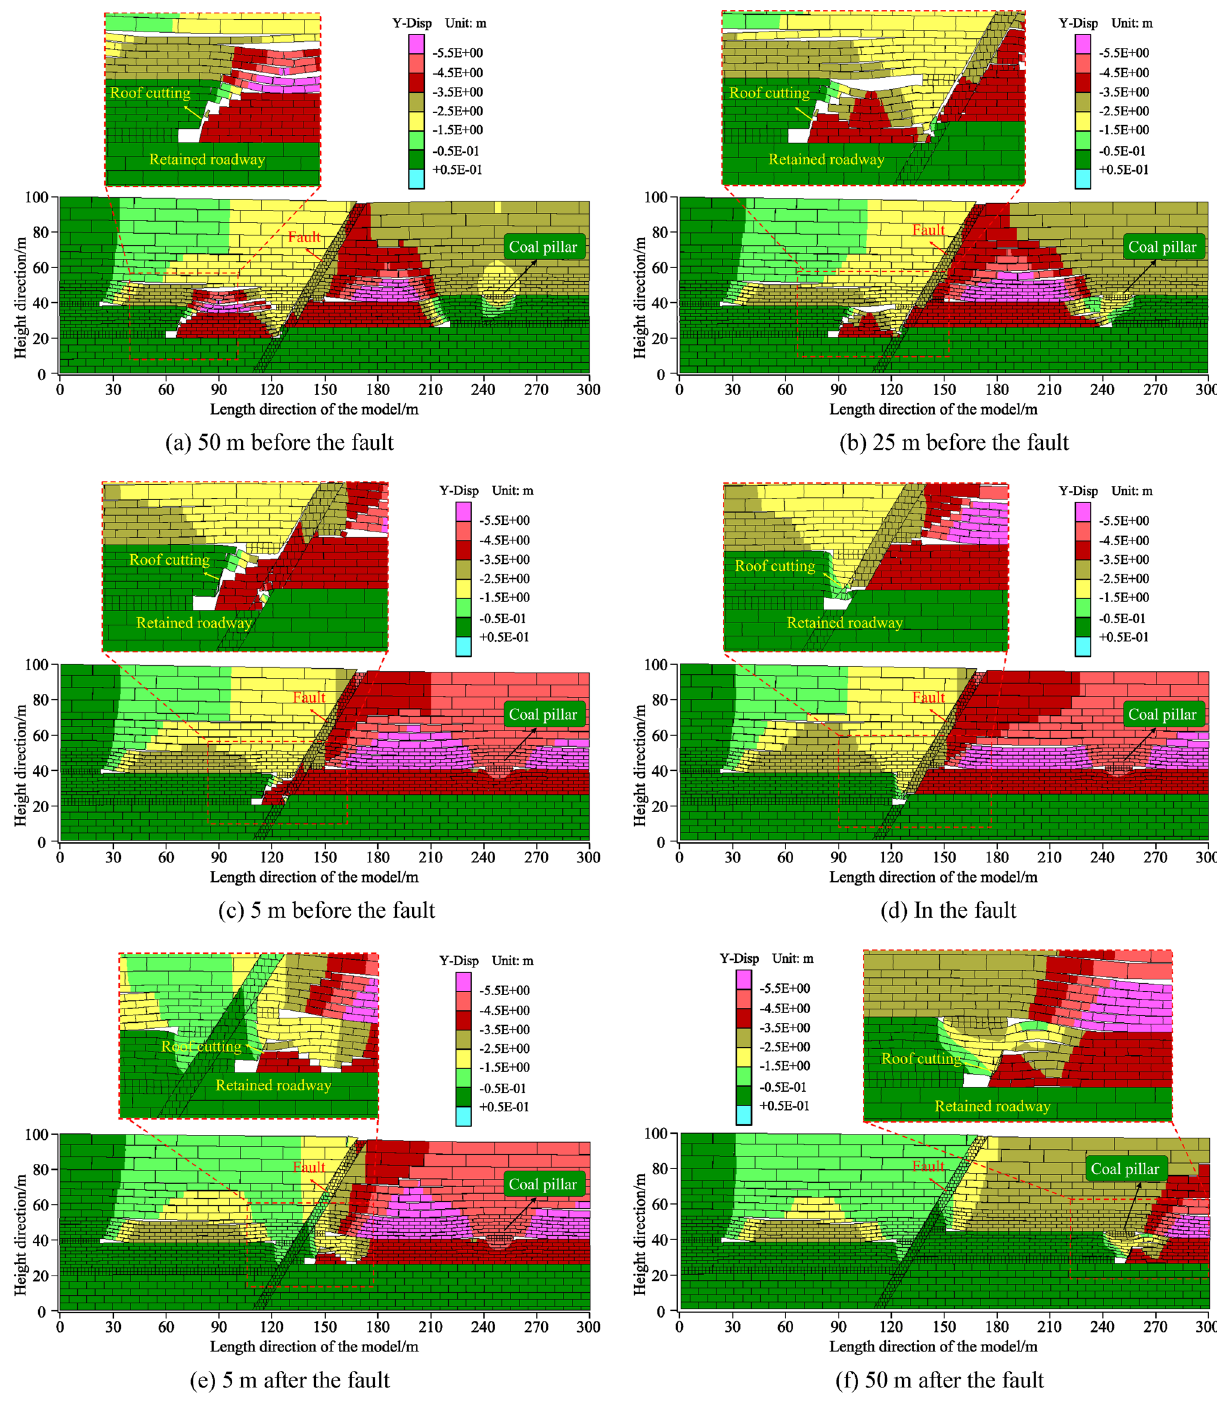
Figure 14. Evolutionary process of the roadway surroundings under different mining and roadway formation